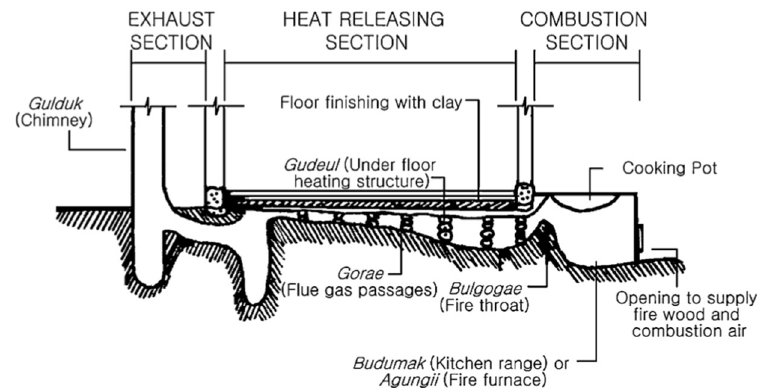
Figure A1. Structure of the traditional Ondol (source: Yeo et al., 2003).